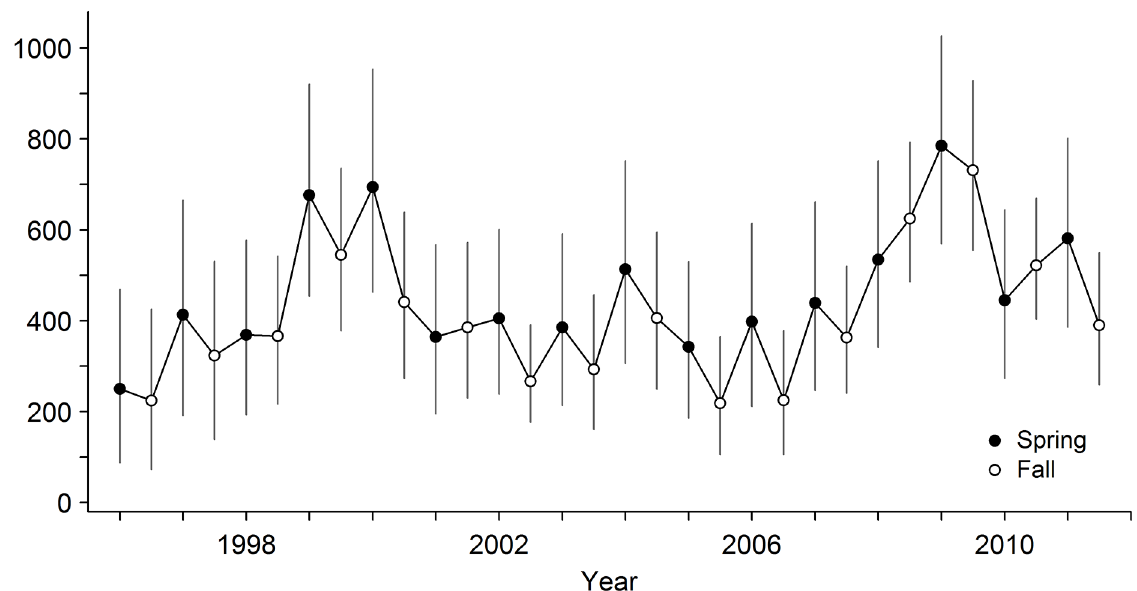
Fig 3. Estimated abundance of adult lowland leopard frogs in the Rincon Mountains, Arizona, USA between 1996 and 2011. Estimated number of adult lowland leopard frogs, with 95% confidence intervals, in four canyons in the Rincon Mountains during spring (1 May – 15 July) and fall (1 October – 30 November). Estimates were obtained using empirical Bayes methods based on a model of recruitment as a function of season, seasonal water availability, number of pools per complex, and connectivity, and a model of survival as a function of season and seasonal water availability (Table 2).